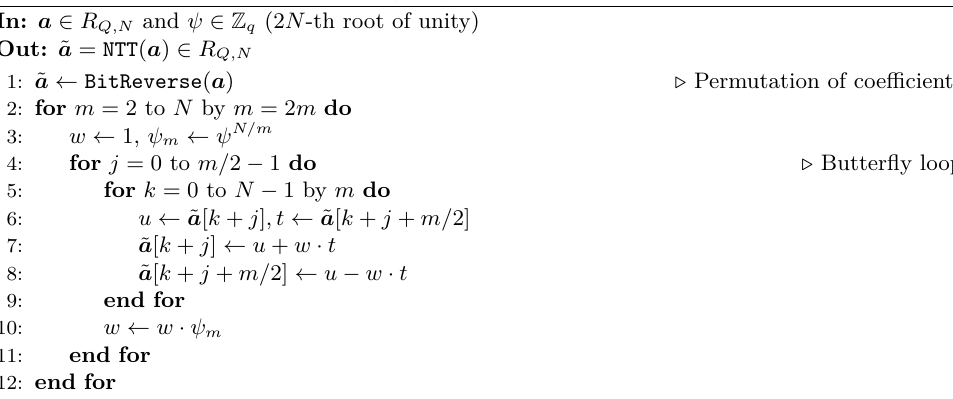
Algorithm 10 Decimation-in-time (DIT) Forward